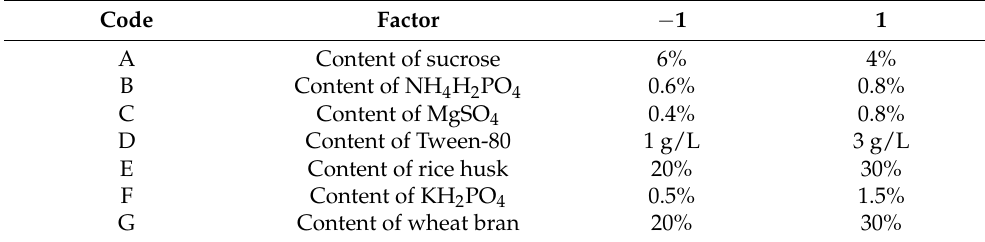
Table 2. The Plackett-Burman experimental